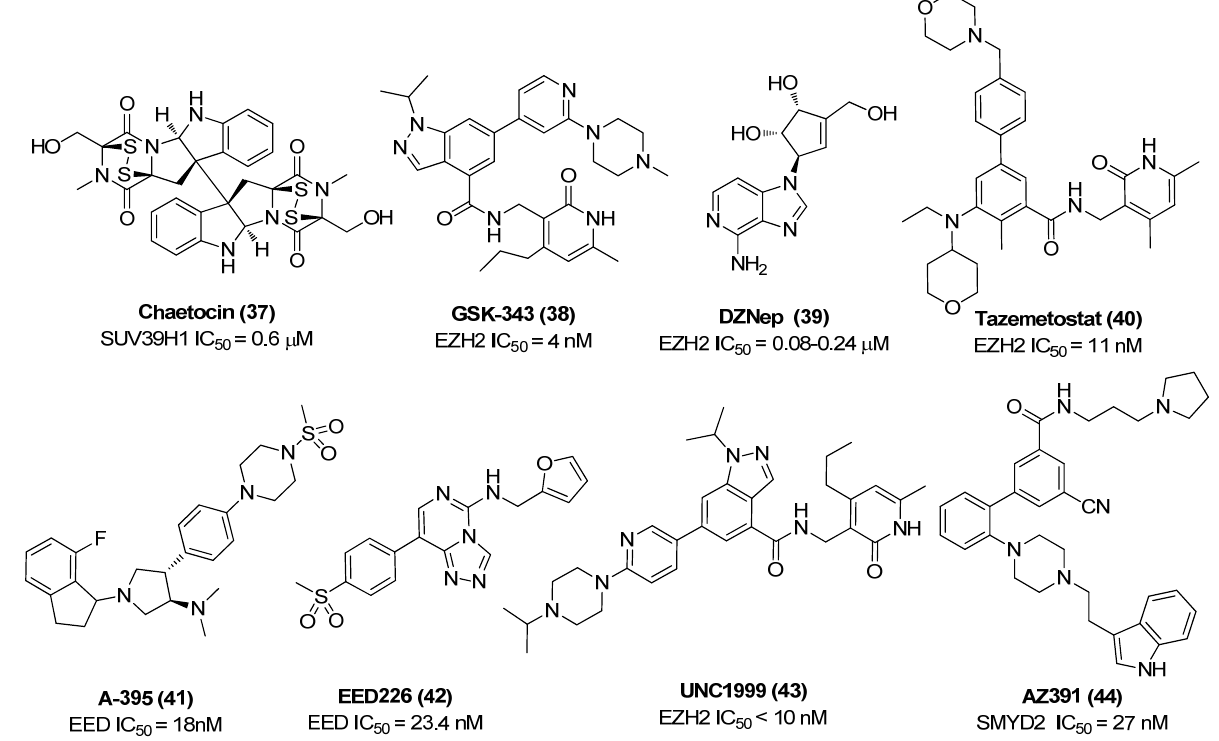
Figure 10. Chemical structures of several identified HMTIs that possess HIV-1 latent reversal effects.